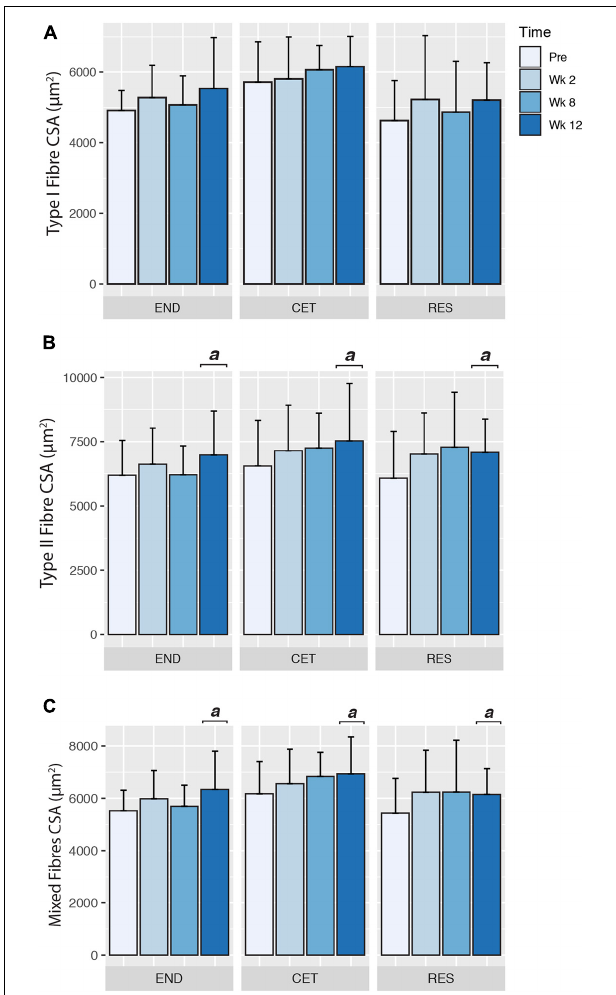
FIGURE 2 | Changes to myosin heavy chain type I (A) , myosin heavy chain type II (B) , and mixed (C) myofibre cross-sectional area (CSA) in response to endurance (END; n = 10), resistance (RES; n = 10), or concurrent (CET; n = 12) training. a, significantly different from Pre time point ( P < 0.05). Values are presented as Mean ±